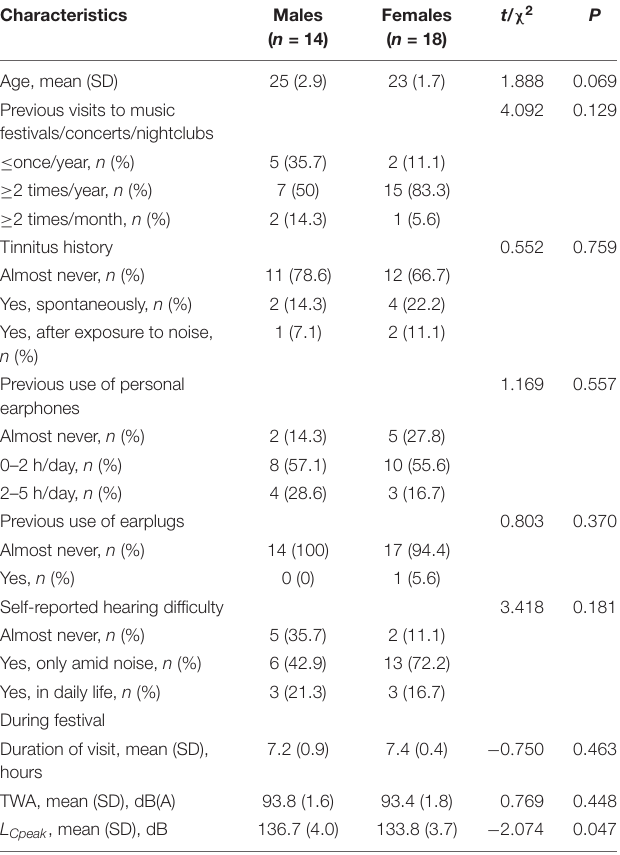
TABLE 1 | Participant characteristics at baseline and during the music festival.